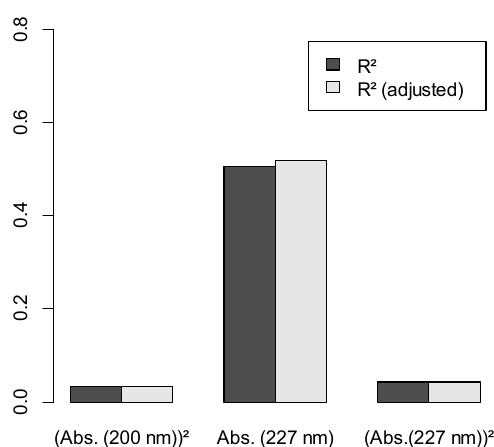
Figure 11. Influence of predictor variables: soluble AOX.